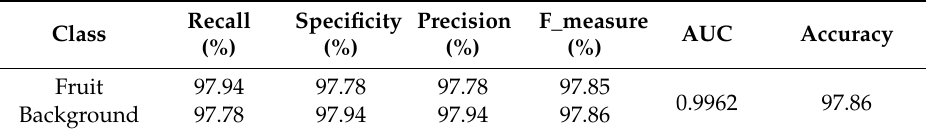
Table 5. The performance of the hybrid ANN-BA classifier base on di ff erent criteria in the best state of training for the testing